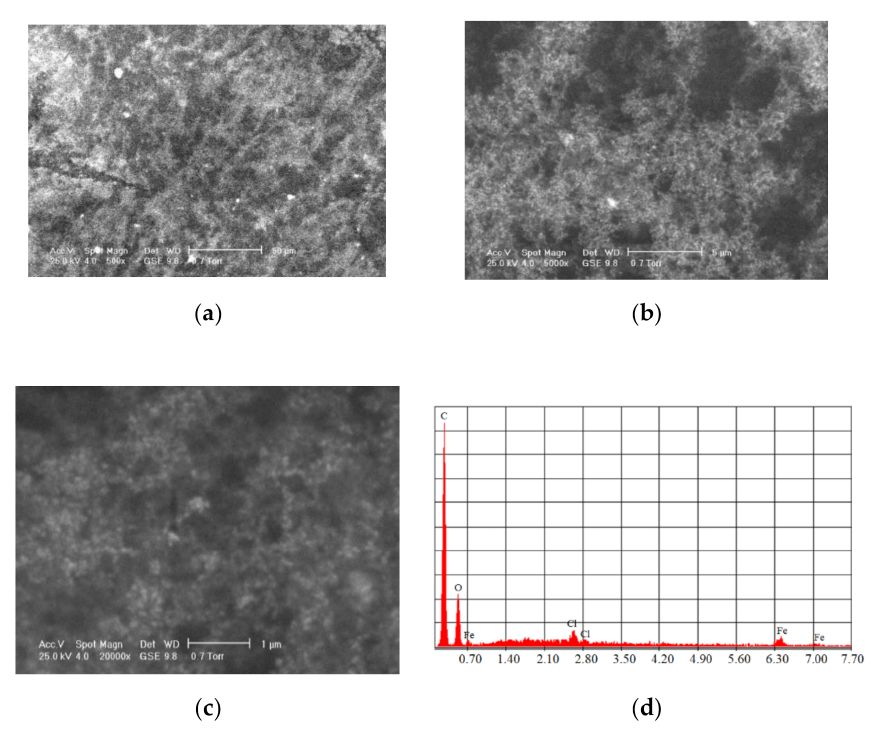
Figure 7. SEM analysis made in the case of Fe 3 O 4 MNPs obtained through the co-precipitation method functionalized with chitosan at different magnification scales: ( a ) 500 × ; ( b ) 5000 × ; ( c ) 20,000 × ; and the resulting elemental analysis ( d ).